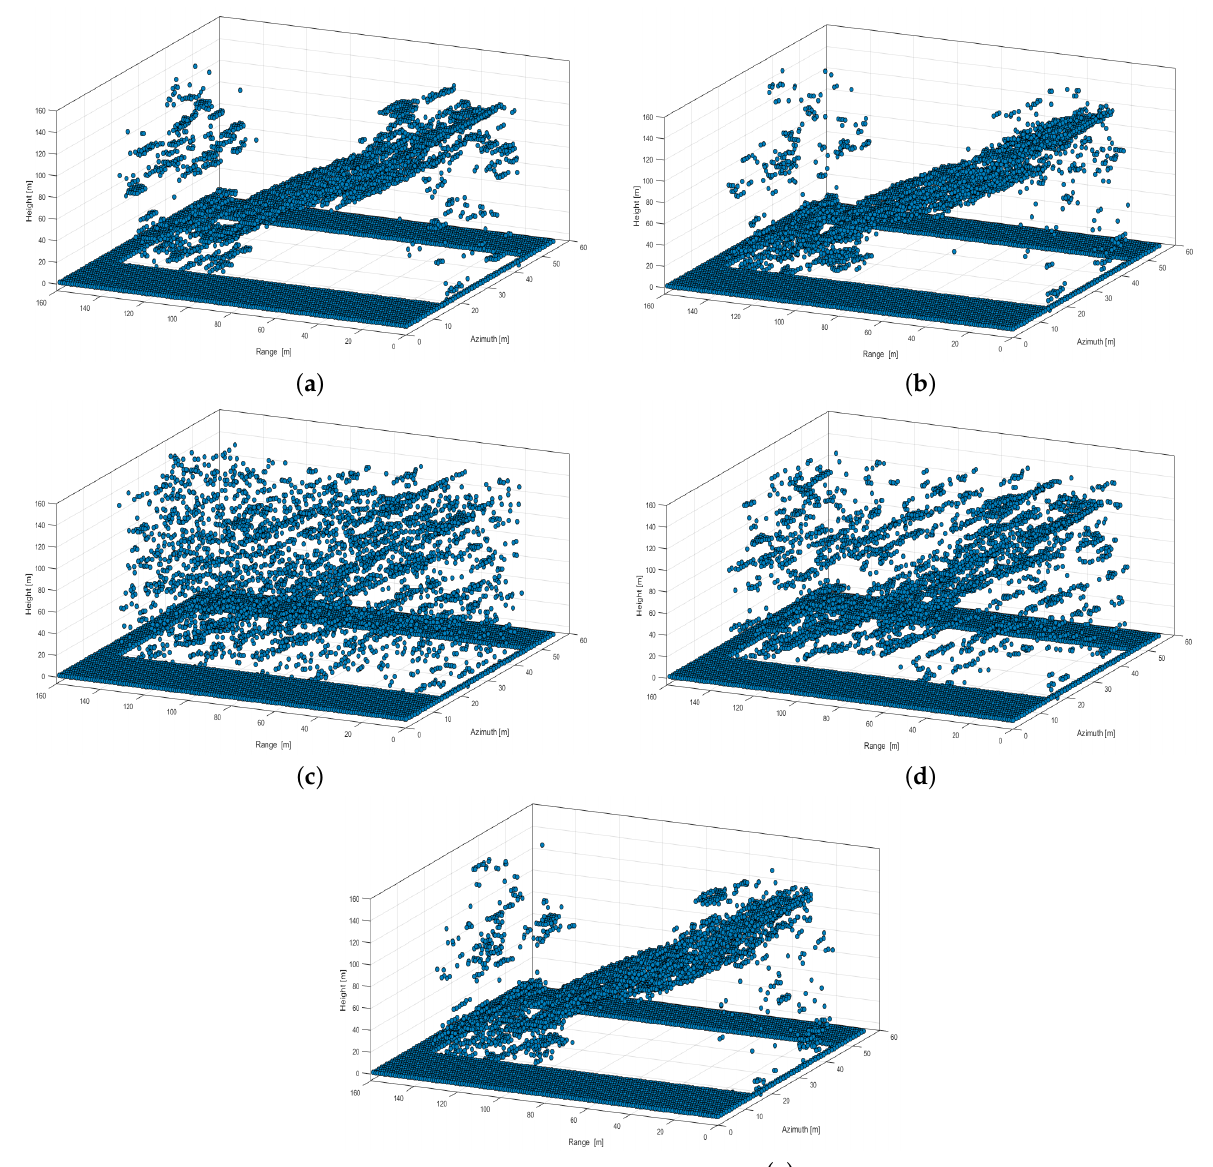
Figure 13. Three-dimensional views of the Arts Hotel height maps generated by the ( a ) Standard MUSIC estimator, ( b ) BIC-MUSIC estimator and ( c ) Minimum-Norm estimator, ( d ) Regularized Minimum-Norm estimator, and ( e ) the proposed non-parametric MUSIC